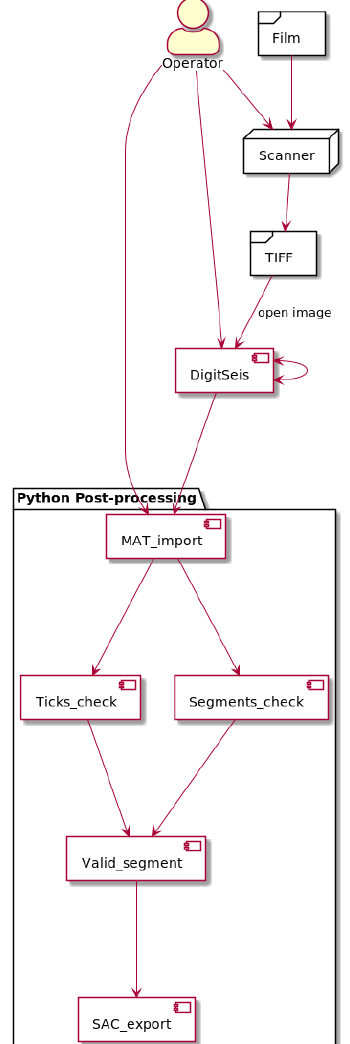
Figure 3. Conceptual flowchart for the technical process. Plotting: